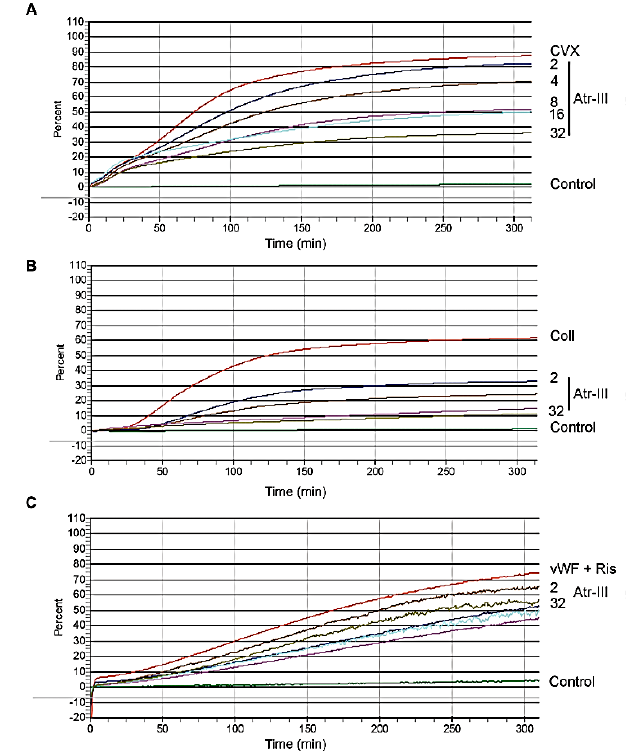
Figure 8. Atr-III inhibits aggregation of platelet stimulated with convulxin (CVX) ( A ) or collagen ( B ) in a concentration-dependent manner. However, it shows little effect on vWF + Ristocetin (Ris)